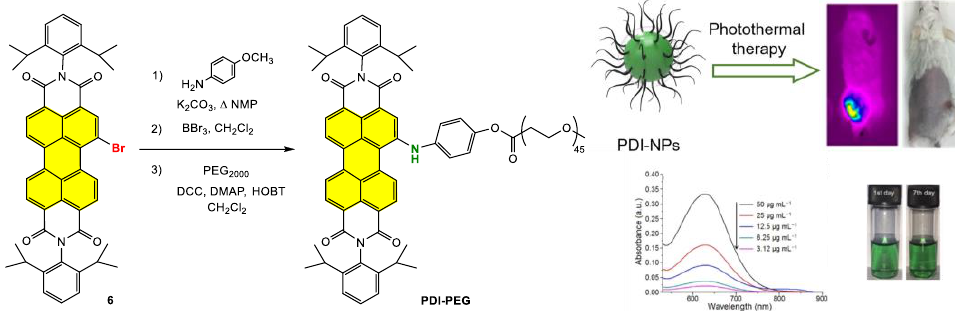
Figure 29. Synthesis of PDI-PEG; representation of PDI-PEG NPs; UV-Visible absorption spectrum of PDI-PEG. Reprinted with permission from reference [140]. Copyright 2018 Elsevier.